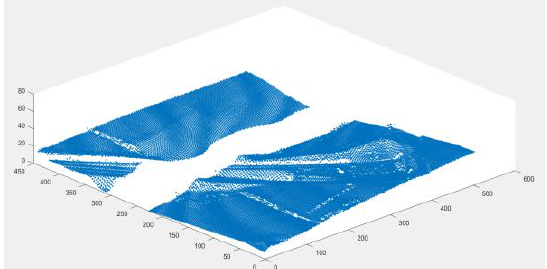
Figure. 3. LiDAR points cloud from ISPRS with low resolution